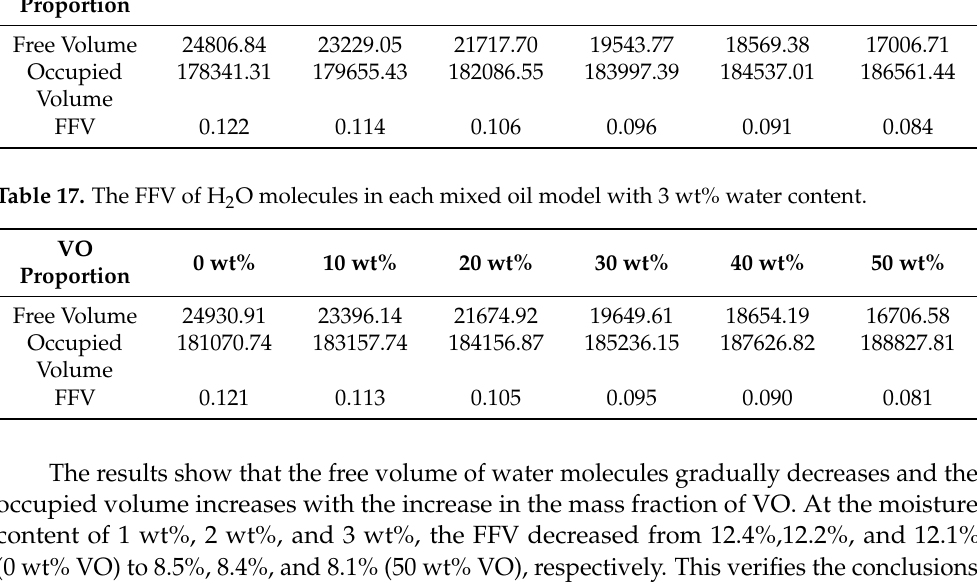
Table 16. The FFV of H 2 O molecules in each mixed oil model with 2 wt% water content. VO Proportion